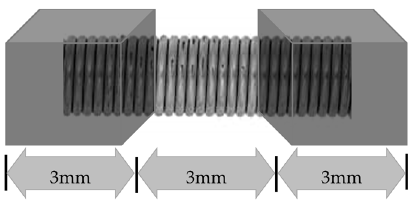
Figure 1. A custom-made NiTi closed coil spring with a middle 3 mm span of active length attached with acrylic blocks on both ends.